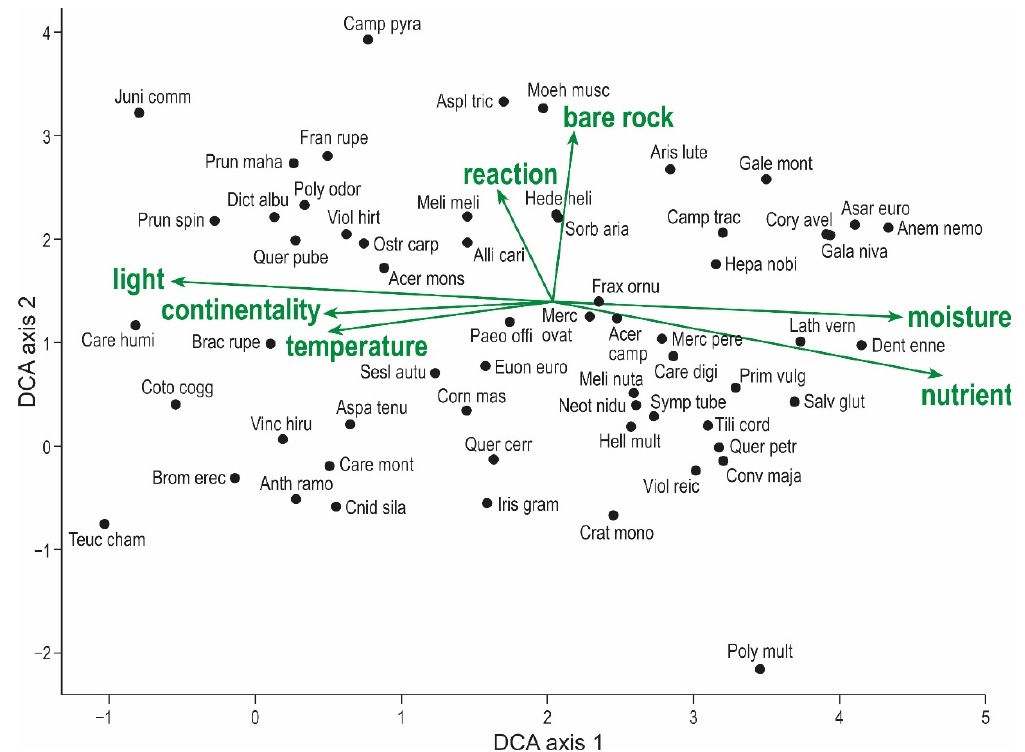
Figure 3. Detrended correspondence analysis (DCA) diagram of species with passively projected bioinicator values. Only half of the species are presented, i.e., which had the best fit to the first DCA axis. Names of species are indicated by four letters indicating genus and four letters for species